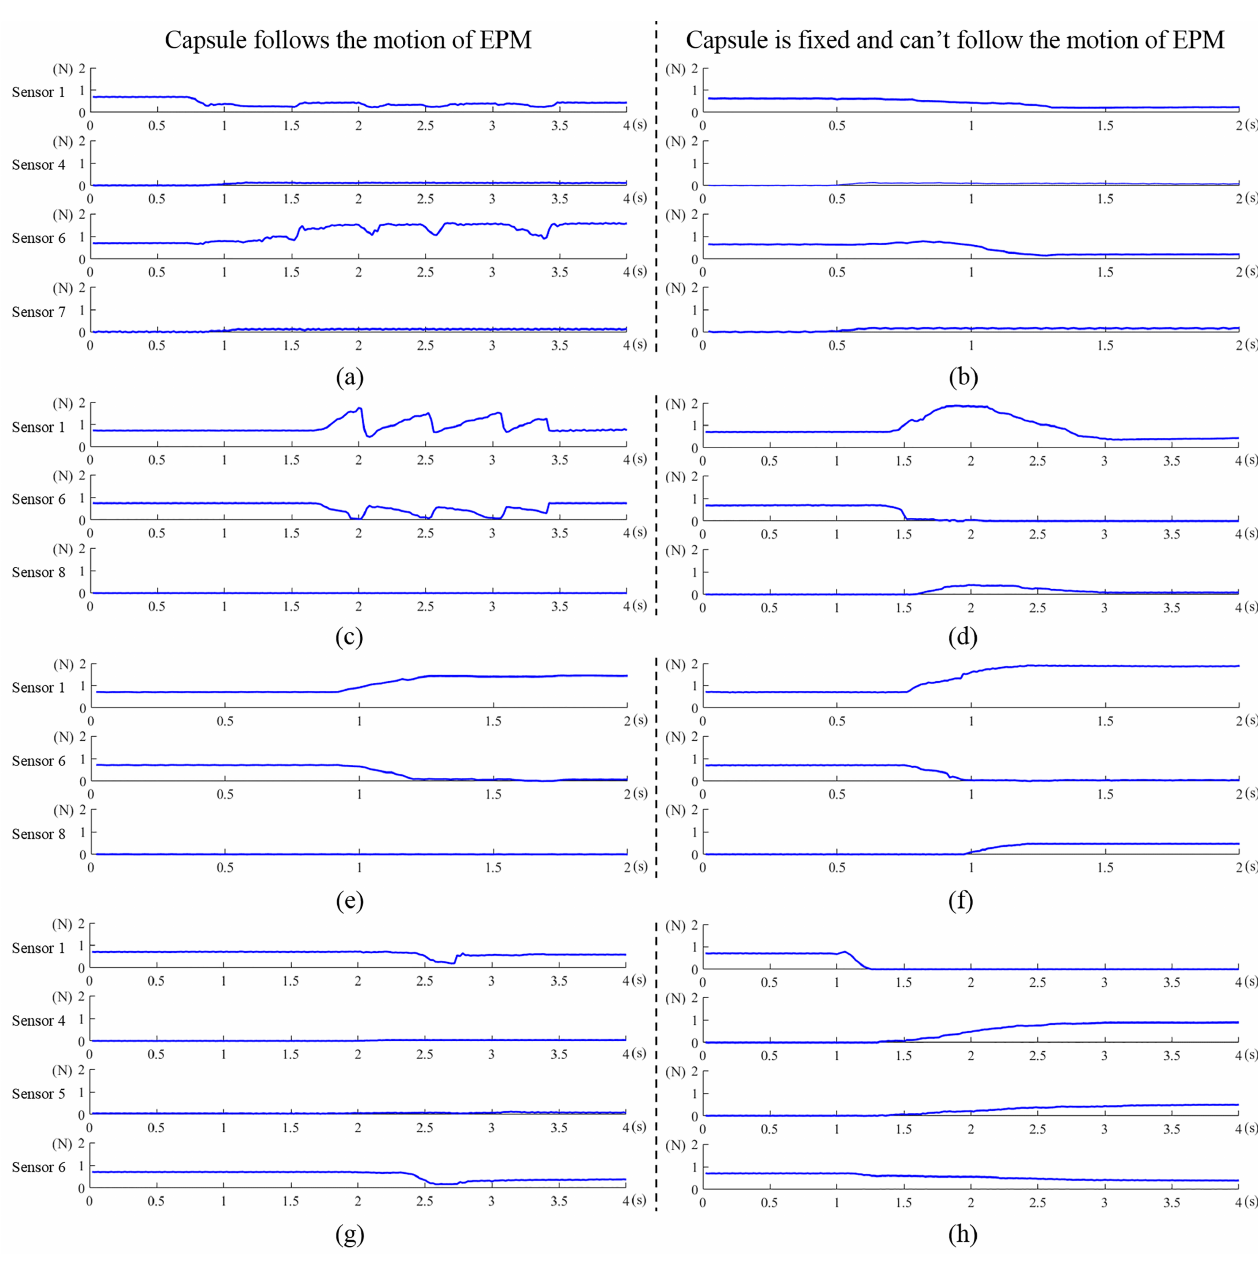
Figure 8. When the EPM moves along various directions, corresponding force signals are measured by force sensitive elements. The abscissa axis of each curve indicates time and the ordinate axis indicates force. ( a ) The EPM translates along its positive X-axis and the magnetic capsule follows its motion. ( b ) The EPM translates along its positive X-axis and the magnetic capsule can’t follow its motion. ( c ) The EPM translates along its positive Y-axis and the magnetic capsule follows its motion. ( d ) The EPM translates along its positive Y-axis and the magnetic capsule can’t follow its motion. ( e ) The EPM rotates along its positive X-axis and the magnetic capsule follows its motion. ( f ) The EPM rotates along its positive X-axis and the magnetic capsule can’t follow its motion. ( g ) The EPM rotates along its positive Z-axis and the magnetic capsule follows its motion. ( h ) The EPM rotates along its positive Z-axis and the magnetic capsule can’t follow its